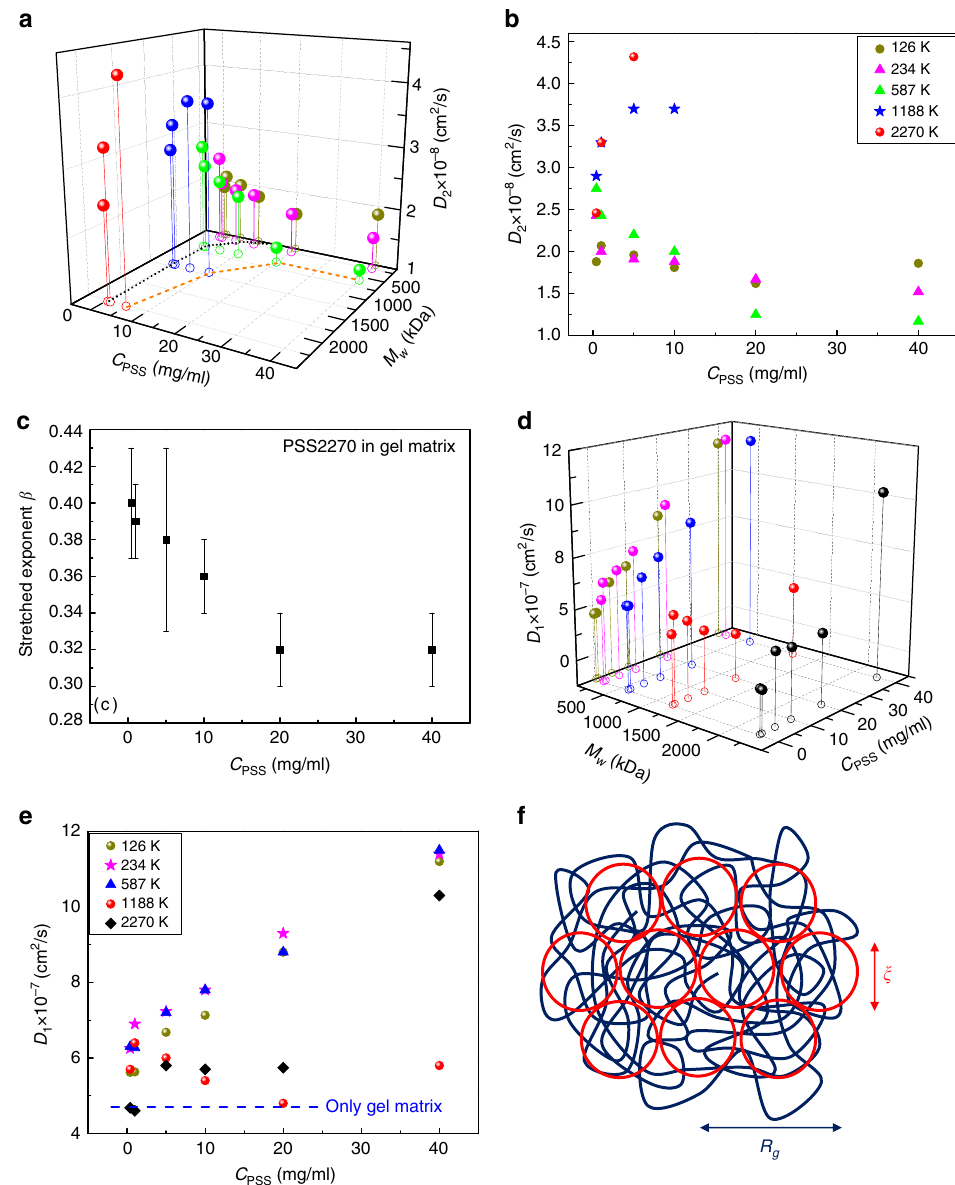
Fig. 7 Diffusion coef fi cients and stretched exponential exponent. a Diffusion coef fi cient of the guest PSS ( D 2 ) inside the gel matrix corresponding to the whole parameter space of Table 1. The un fi lled circles are the projections of the values of D 2 denoting the corresponding coordinate values of C PSS and M w . The orange dashed line is the boundary of dynamical transition for PSS in the gel matrix and the blue dotted line is the overlap concentration C * as a function of M w for PSS in solutions. b The corresponding numerical values of a . Same colors indicate the same M w in a , b . c Average value of β at different PSS concentrations for PSS2270. Each of the data points denotes the average of three individual replicates, and error bars are ± sd. d Elastic diffusion coef fi cient of the gel ( D 1 ) corresponding to the whole parameter space of Table 1. The un fi lled circles are the projections of the values of D 1 denoting the corresponding coordinate values of C PSS and M w . e The corresponding numerical values of d . The dashed blue line indicates the elastic diffusion coef fi cient ( D 1 ) of the gel matrix without PSS. Same colors indicate the same M w in d , e . f Cartoon of partitioning of monomers of a single con fi ned chain into a large number of meshes (in three